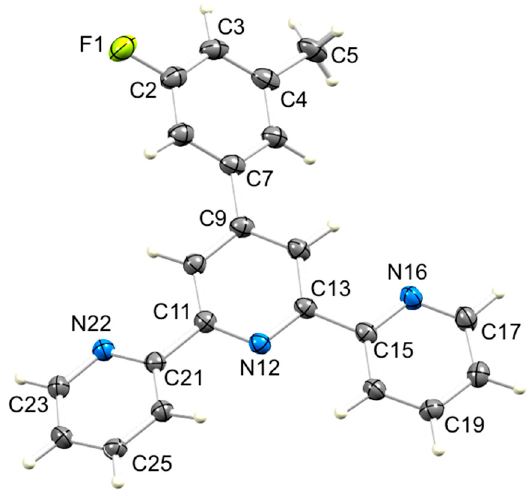
Figure 5. ORTEP-style diagram of molecule 3 with ellipsoids plotted at 50% probability level. Selected bond parameters: F1–C2 = 1.3686(17), C4–C5 = 1.509(2), C7–C9 = 1.4945(18), C11–N12 =